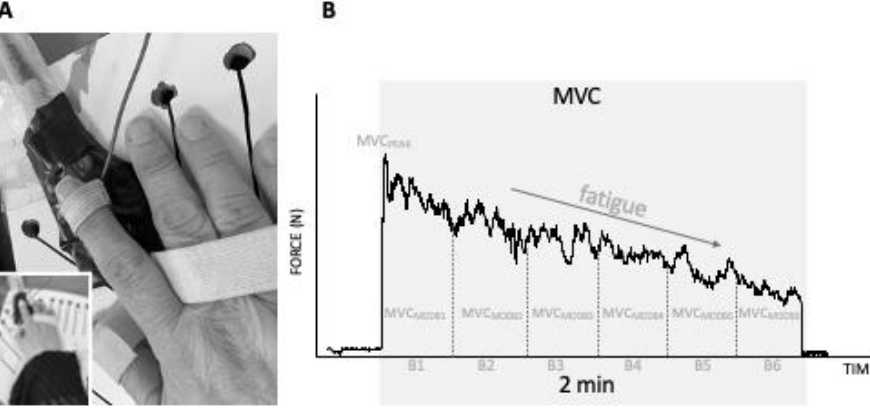
Figure 1. ( A ). The fixation system and hand preparation to execute the isometric task with an adapted dynamometer. ( B ). An example of a two-minute isometric task register. The isometric task is evaluated with the modulus of maximal voluntary contractions (MVC MOD ) in 20 s periods (B1, B2, B3, B4, B5 and B6). The force measured in Newton (N) decreases along the 2 min and is at the maximum at the beginning of the task (MVC PEAK ).